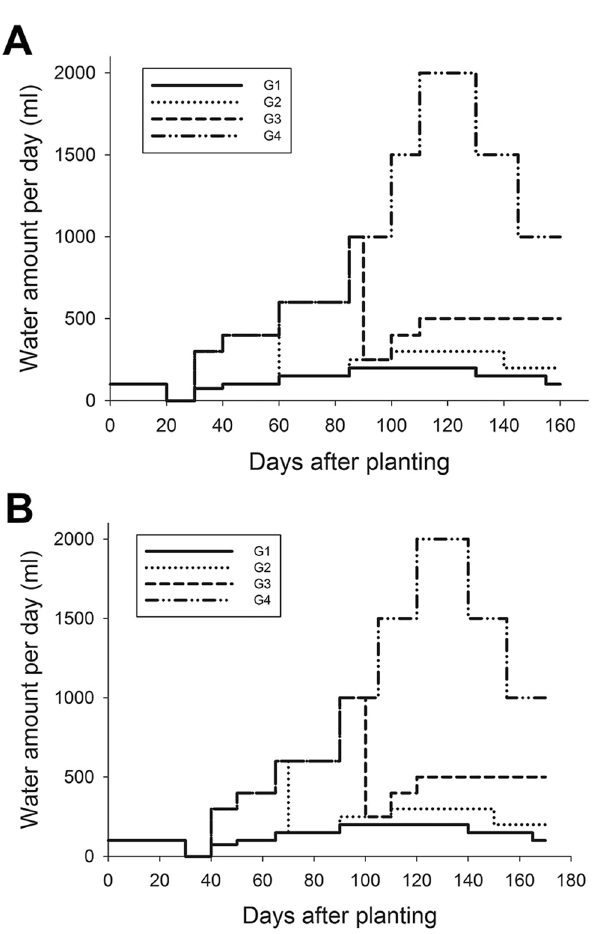
Figure 5. Experimental design for differential irrigation experiments in greenhouse. G1, G2, G3, and G4, four groups of plants with different irrigation amount and